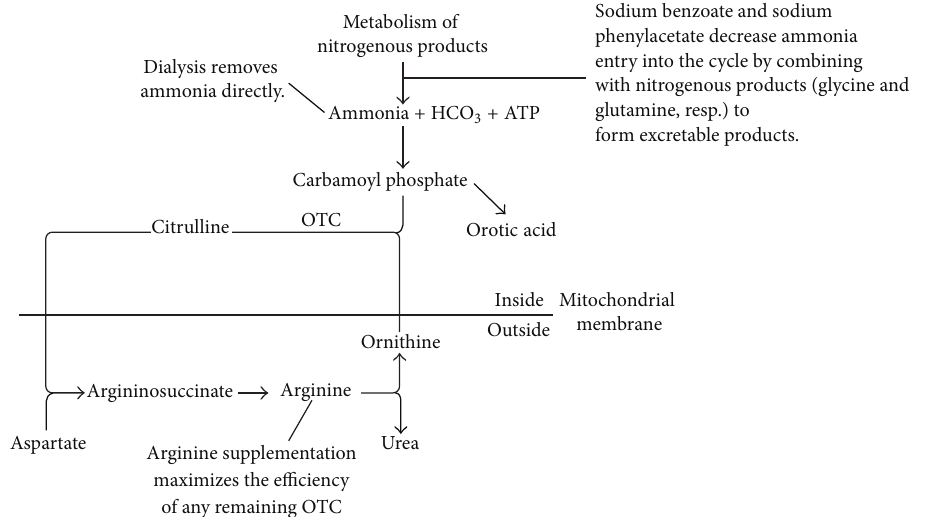
Figure 4: The urea cycle, demonstrating steps at which interventions are targeted in OTCD. ATP: adenosine triphosphate. ASAS: argininosuccinate synthetase. ASAL: argininosuccinate lyase. ARG-1: arginase